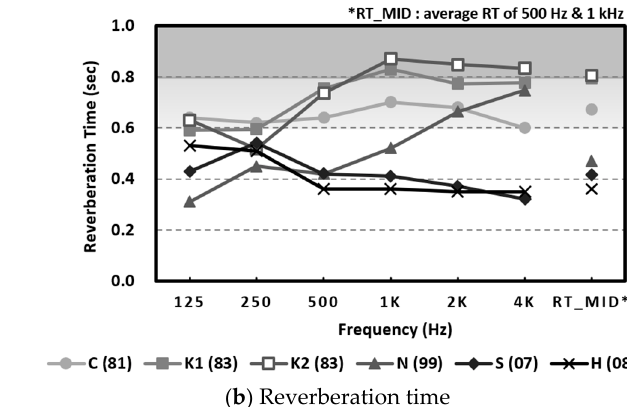
Figure 2. Measurement results of background noise levels and reverberation time in Korean ele- mentary school classrooms (unoccupied).